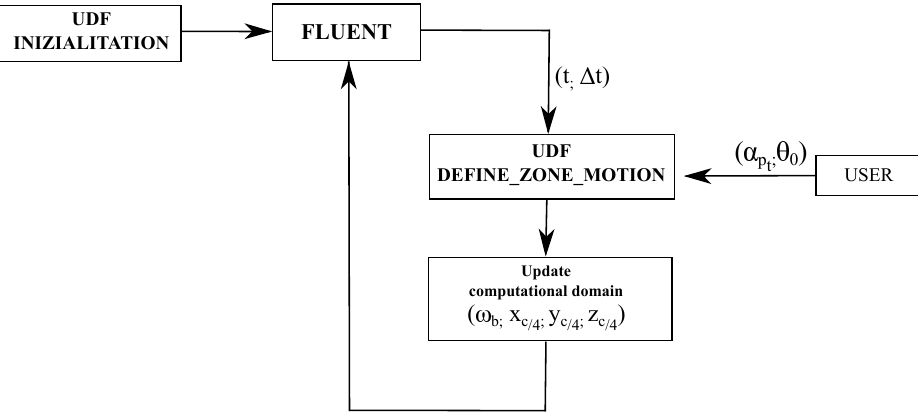
Figure 10. Flow chart of DEFINE _ ZONE _ MOTION